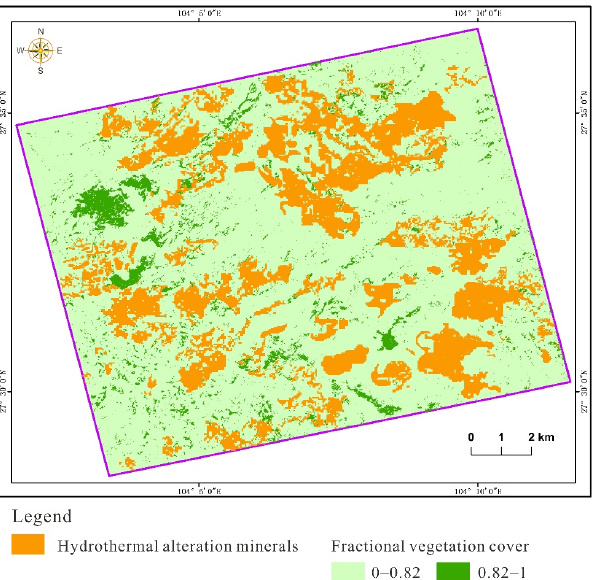
Figure 11. Overlay analysis of vegetation cover and hydrothermal alteration minerals.